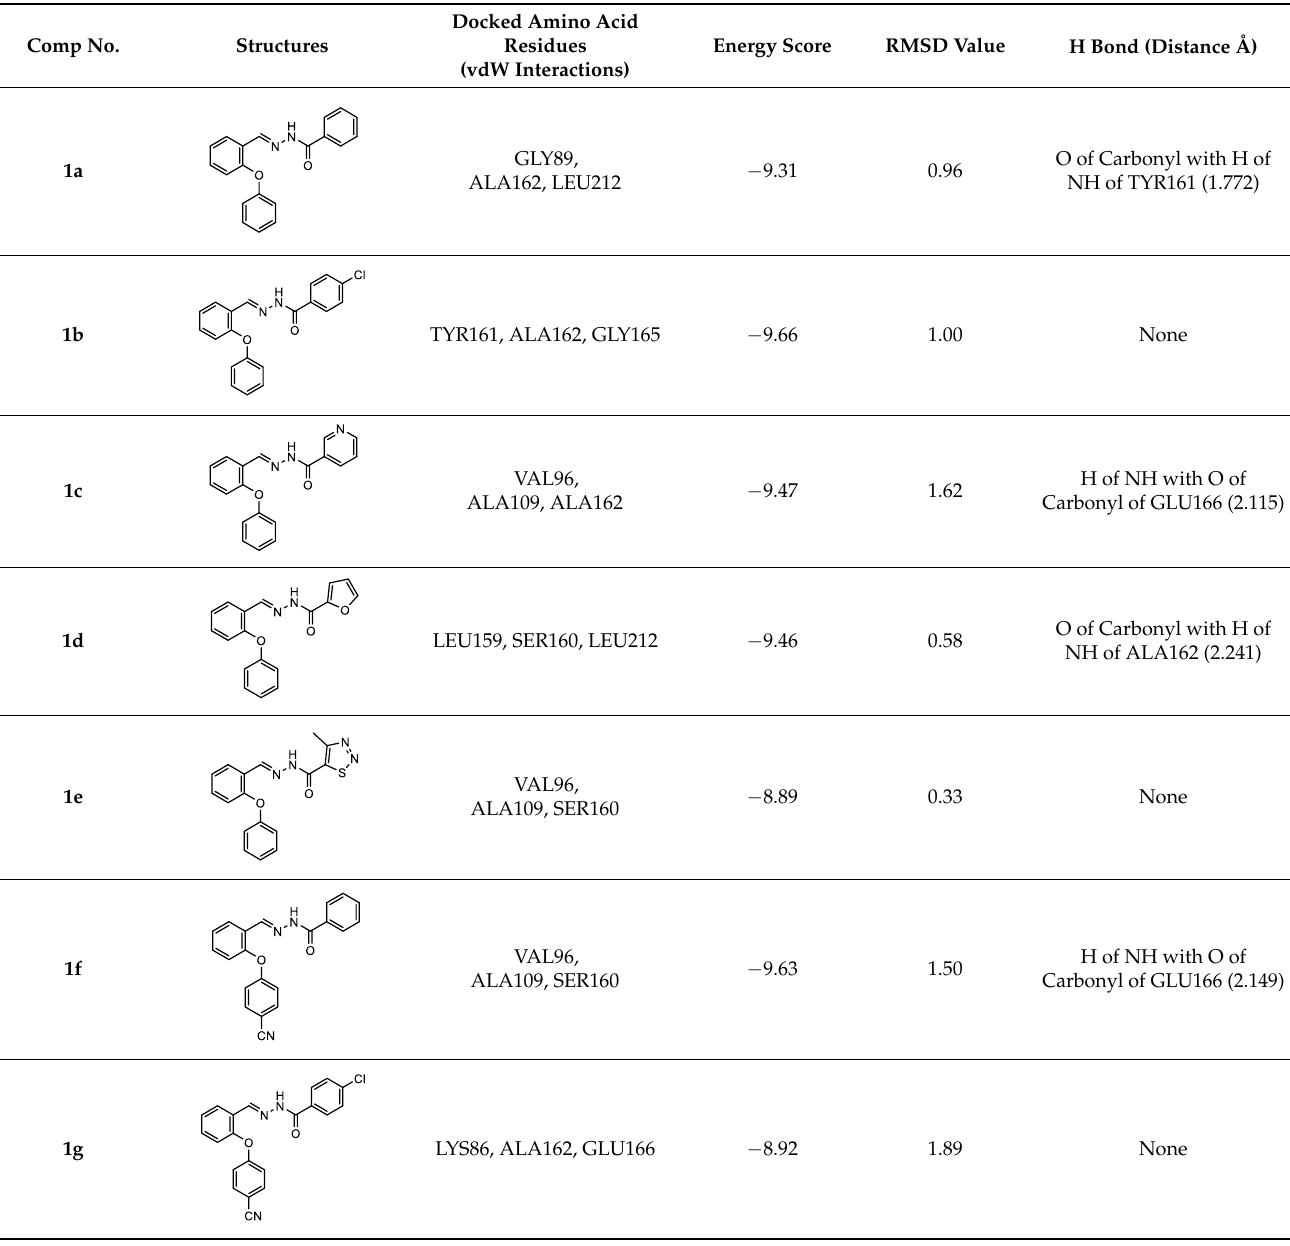
Table 2. Docking results of phosphoinositide-dependent kinase-1 (1Z5M). Comp No.